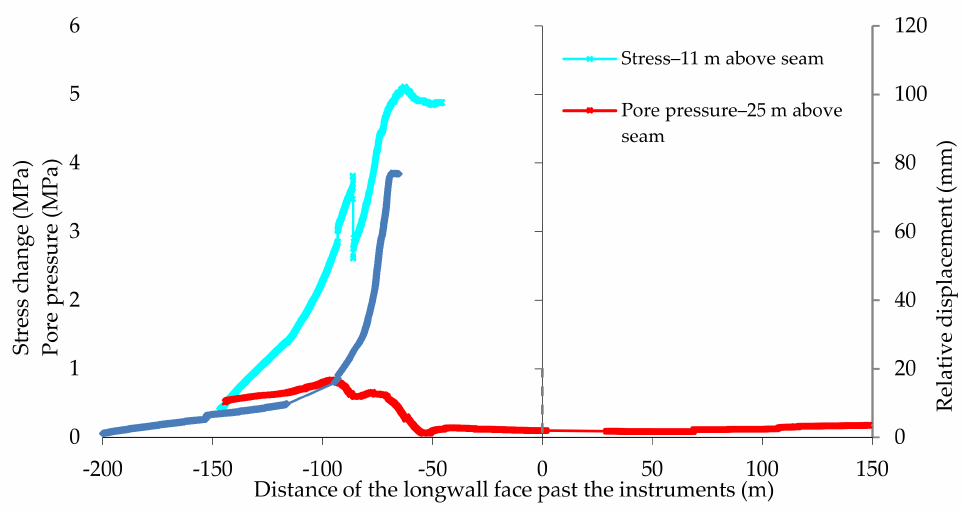
Figure 9. Corresponding changes of strata stress, deformation and pore pressure monitored at LW 5121(5).